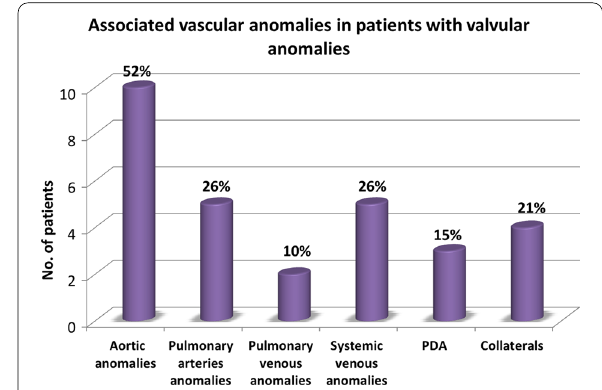
Fig. 4 Bar graph showing Associated vascular anomalies in patients with valvular anomalies